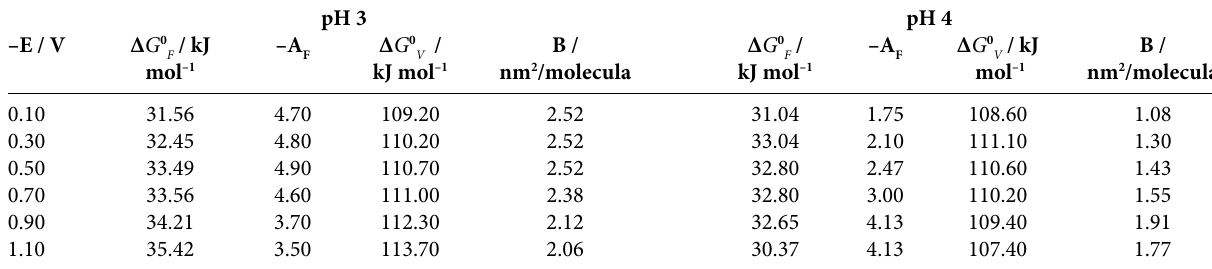
Gugała-Fekner: The Effect of Adenine Adsorption on Zn (II)